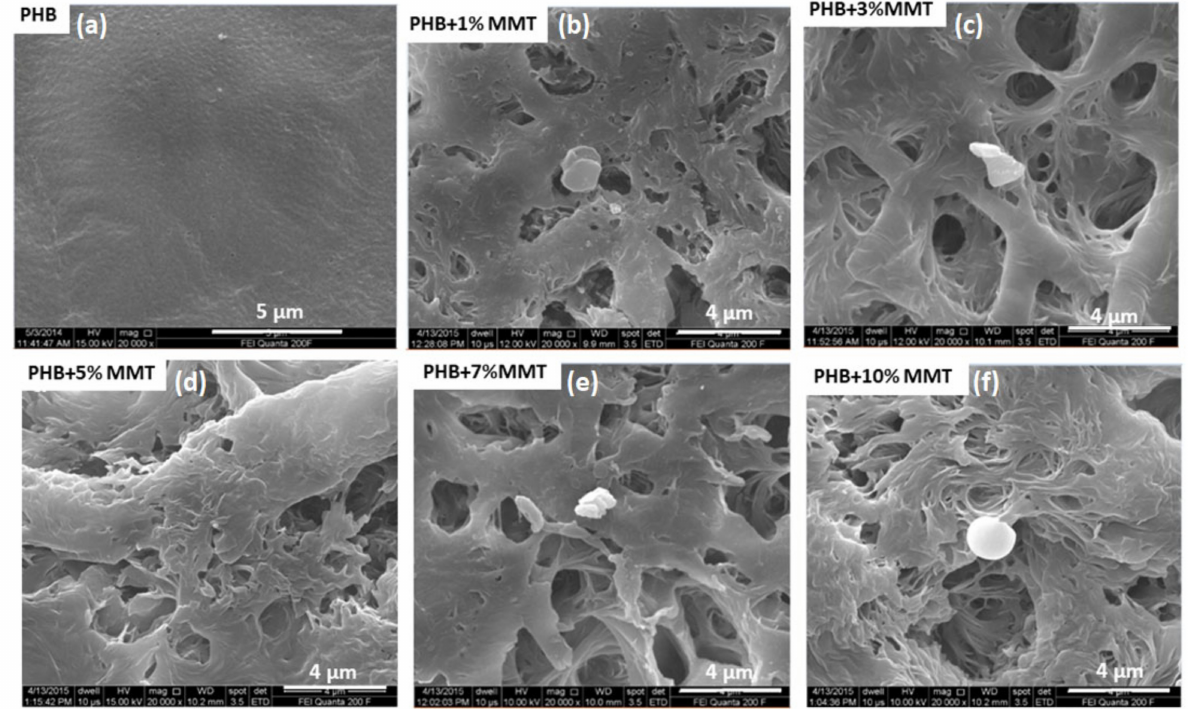
Figure 1. SEM images of nanocomposite films of ( a ) PHB control, ( b ) 1 wt% OMMT, ( c ) 3 wt% OMMT, ( d ) 5 wt% OMMT, ( e ) 7 wt% OMMT, and ( f ) 10 wt%